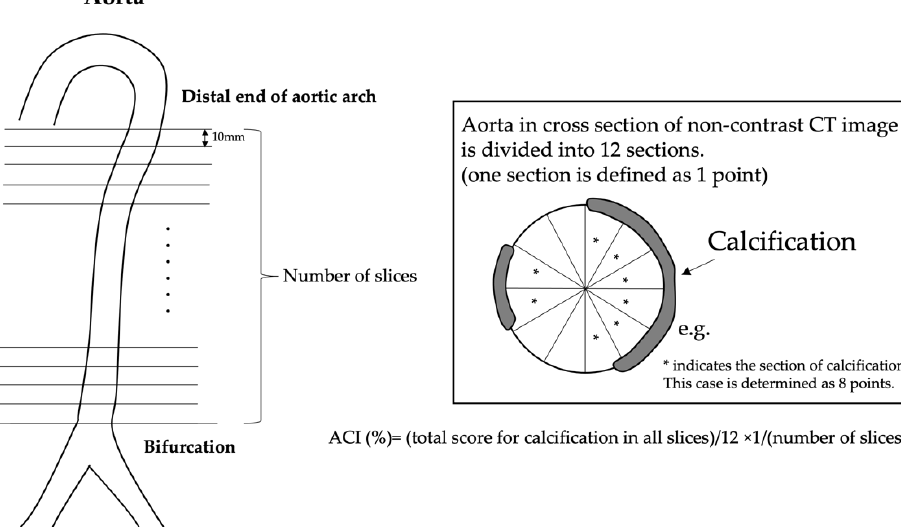
Figure 1. Evaluation of aortic calcification. The calcification of aorta was calculated from the distal end of aortic arch to the bifurcation of the aorta into the common iliac arteries. The cross section of the aorta on each slice was divided radially into 12 segments [12]. The aortic calcification index (ACI) was calculated as follows: ACI = (total score for calcification in all slices)/12 × 1/(number of slices) × 100 (%) [13,14].